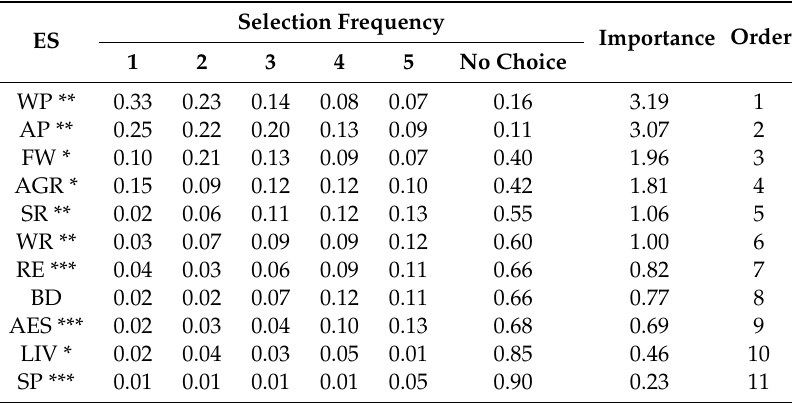
Table A2. The scores and order of ecosystem services.